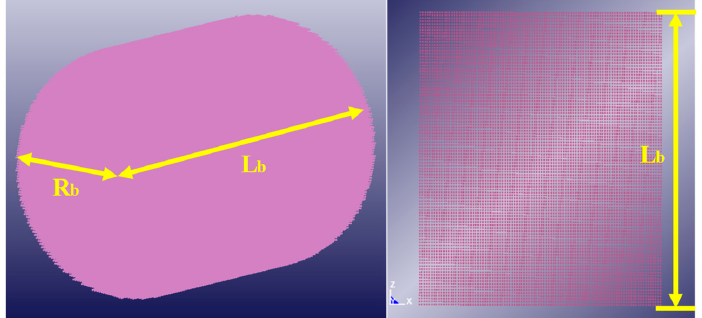
Figure 2. Cylindrical projectile consists of particles.